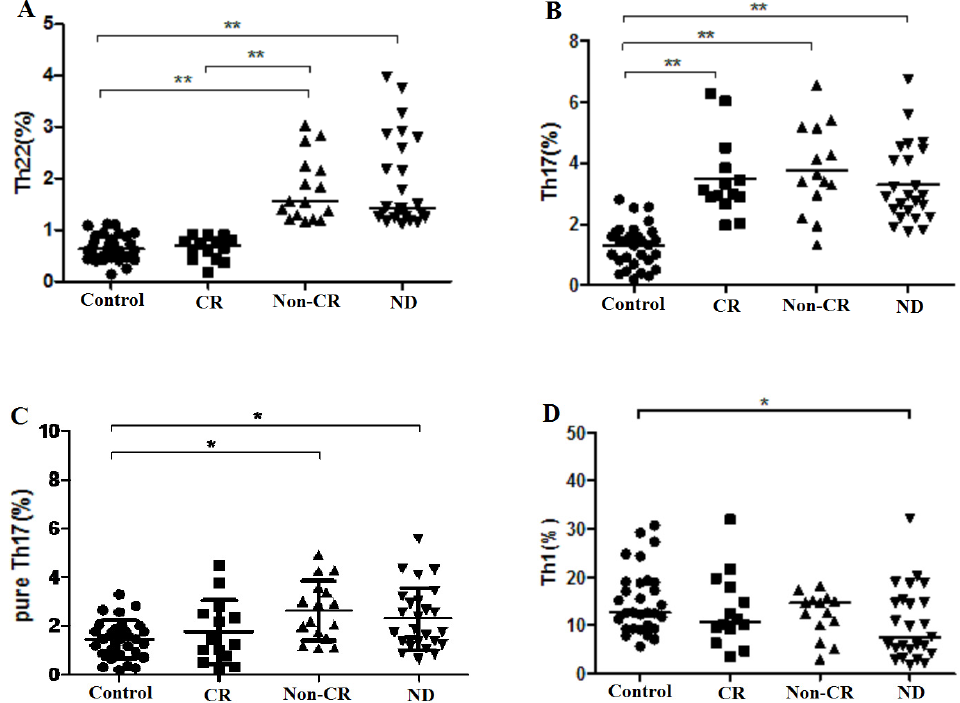
Figure 2. The results of circulating Th subsets in healthy controls, CR AML patients, Non-CR AML patients, and ND AML patients. ( A ) The percentages of circulating Th22 (CD4 + IFN- γ − IL17 − IL-22 + ) cells; ( B ) The percentages of circulating Th17 (CD4 + IL-17 + ) cells; ( C ) The percentages of circulating pure Th17 (CD4 + IFN- γ − IL-22 − IL-17 + ) cells; ( D ) The percentages of circulating Th1 (CD4 + IFN- γ + ) cells. Data was shown as Median (range). * p < 0.05, ** p < 0.0001.